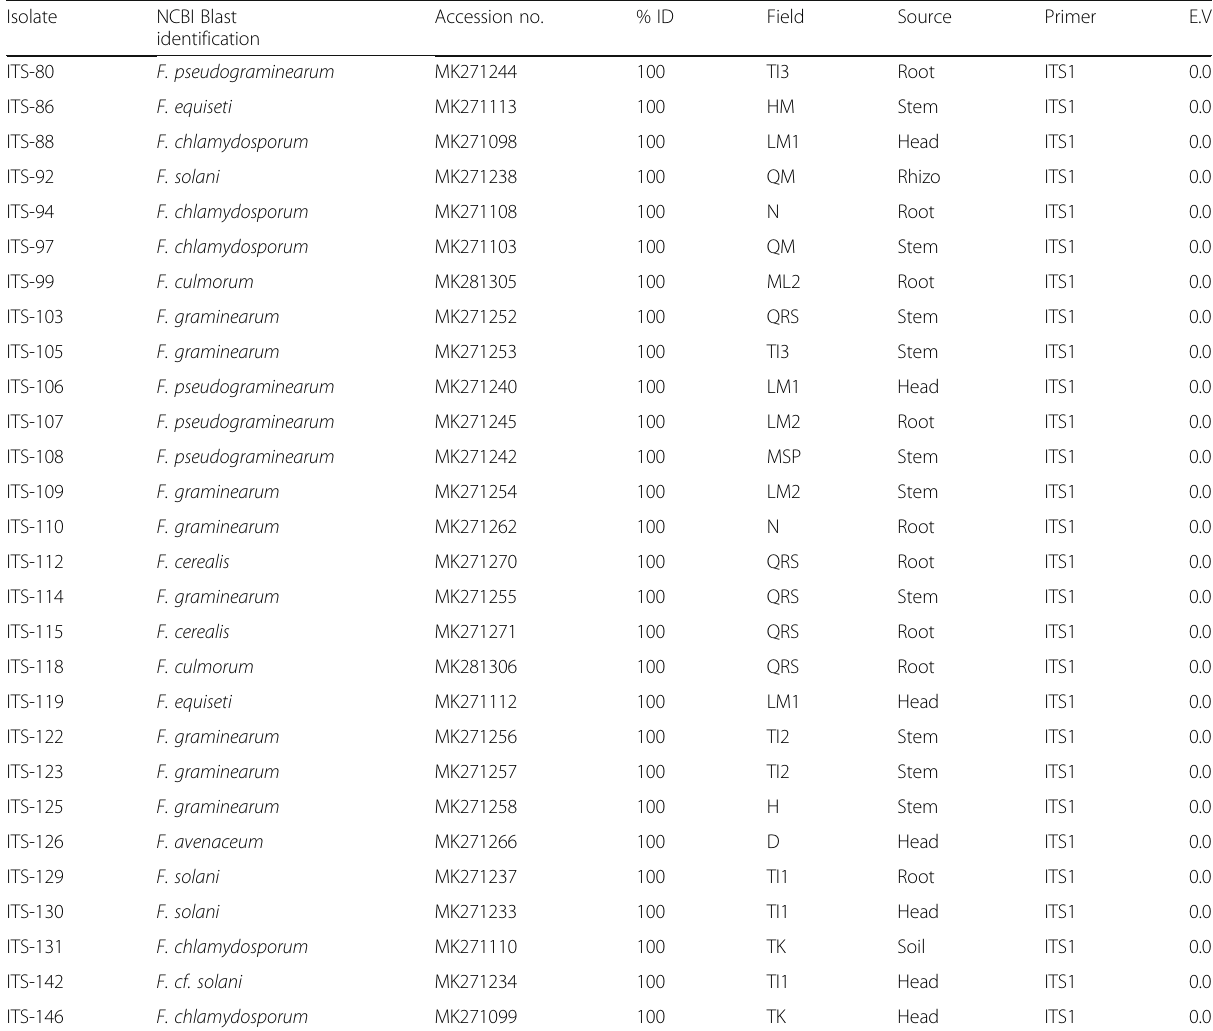
Table 1 Identification of Fusarium taxa isolated from the selected wheat fields based on the sequencing of rDNA ITS1-5.8S-ITS4 region